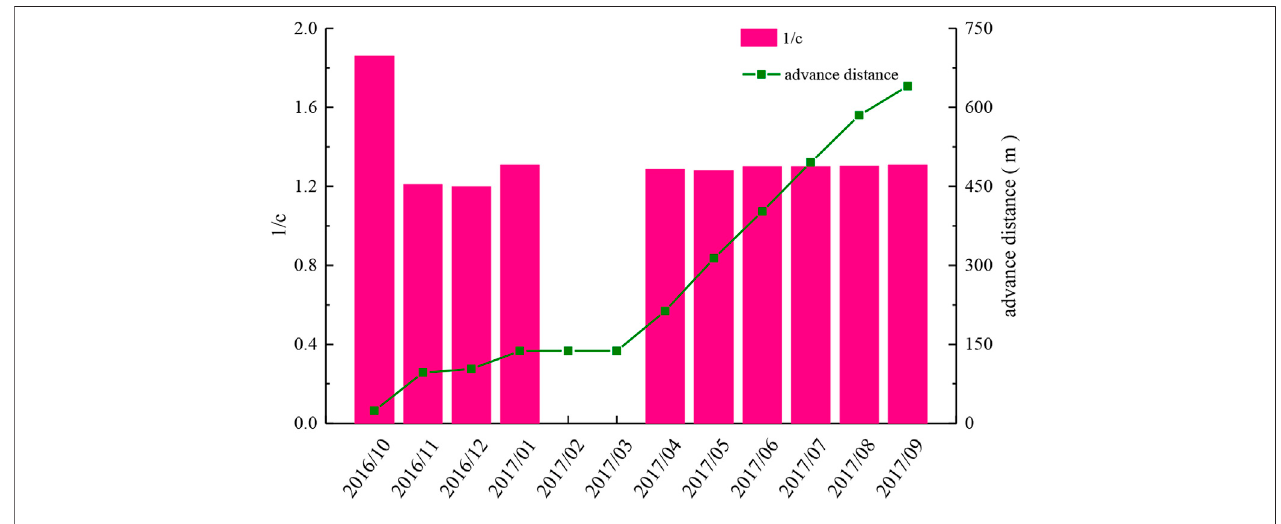
FIGURE 7 | Distribution of mass ratio of mining and back fi lling in coal mining.